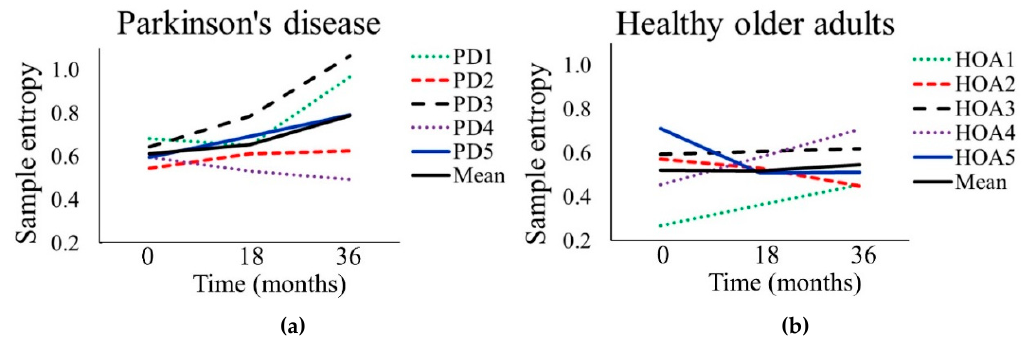
Figure 6. Sample entropy of stride time over a 36-month period for ( a ) five people with Parkinson’s disease (PD1–PD5) and ( b ) five healthy older adults (HOA1–HOA5). Table 4. Sample entropy for five participants with Parkinson’s disease and five older adults at TP1, TP2, and